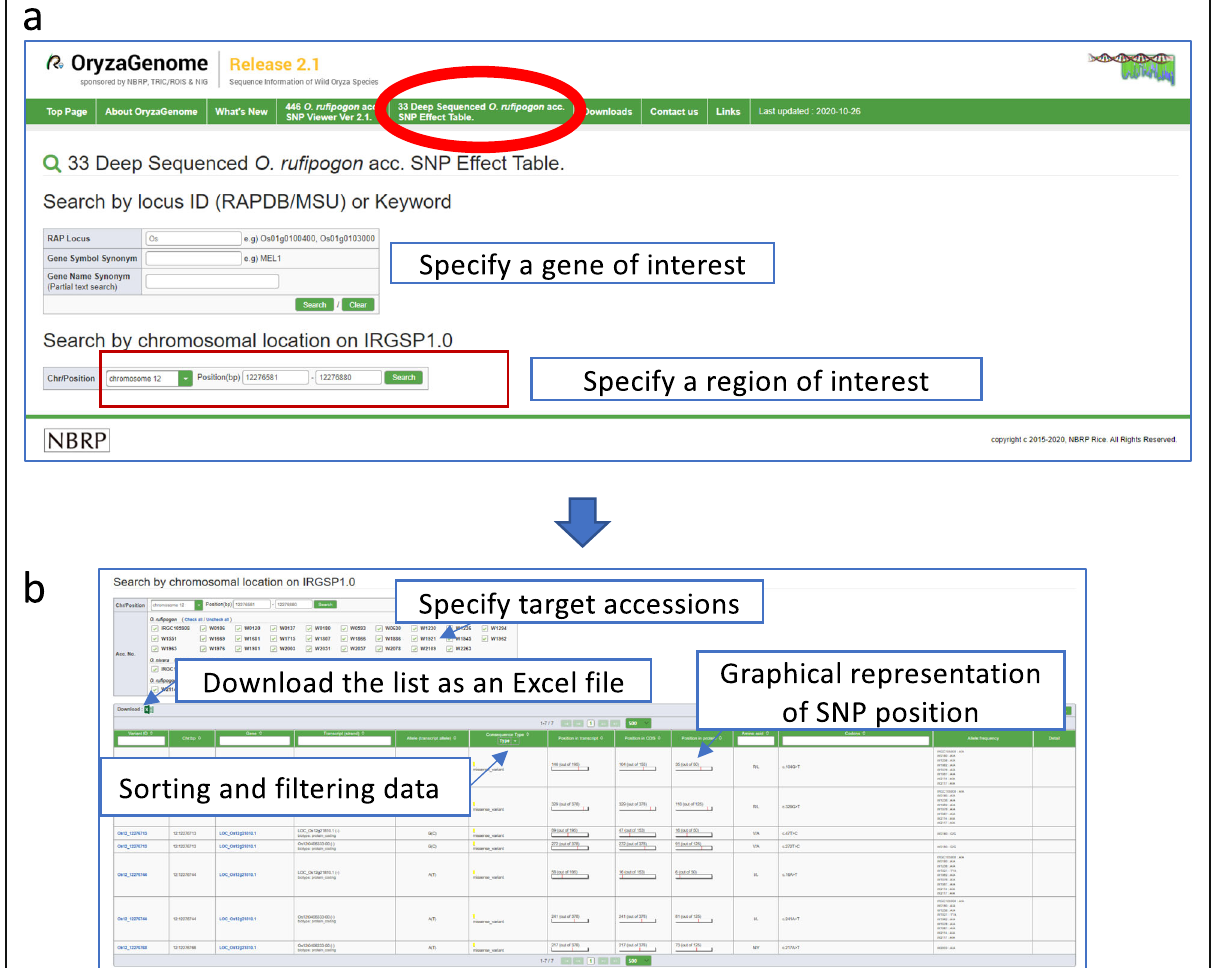
Fig. 3 SNP Effect Table. a A new function allows users to search for SNPs with specific characteristics in the 33 Deep-Sequenced Oryza rufipogon Accessions by gene locus ID or IRGSP1.0 chromosome coordinate, and ( b ) the resultant SNP list is displayed in tabular